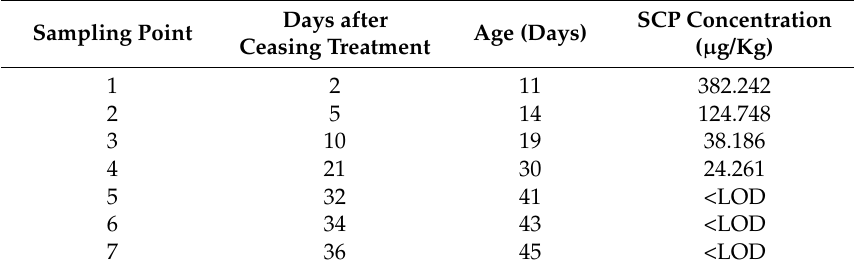
Table 4. SCP concentration in droppings from broiler chickens who were treated with a commercial formulation, by sampling